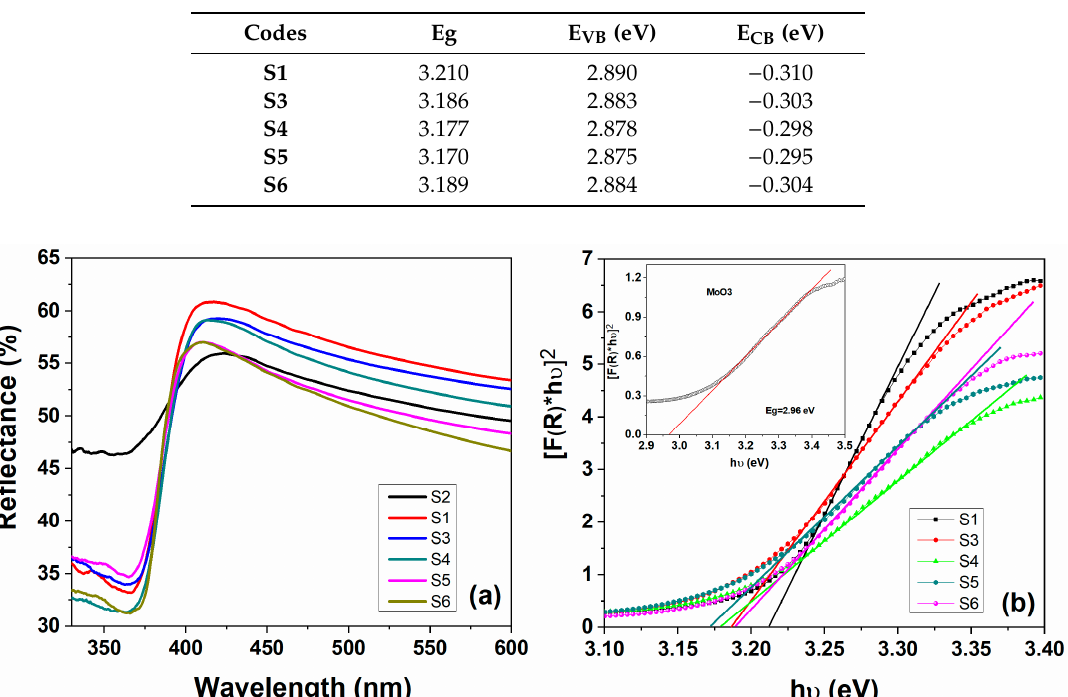
Figure 6. Di ff use reflectance ultraviolet–visible (UV–vis) spectra ( a ) and plots of [ F ( R ) h ϑ ] 2 versus h υ Figure 6. Diffuse reflectance ultraviolet–visible (UV–vis) spectra ( a ) and plots of [(cid:1832)((cid:1844))ℎ(cid:2036)] (cid:2870) versus h υ ( b ) for pure ZnO (S1), MoO 3 (S2) ( inset ), and ZnO:MoO 3 (S3 → S6) nanostructures. ( b ) for pure ZnO (S1), MoO 3 (S2) ( inset ) , and ZnO:MoO 3 (S3 → S6) nanostructures. The plots of [ F ( R ) h ϑ ] 2 as a function of the photon energy ( h ϑ ) of all the materials are presented in The plots of [(cid:1832)((cid:1844))ℎ(cid:2036)] (cid:2870) as a function of the photon energy ( ℎ(cid:2036) ) of all the materials are presented (Eg) were obtained. The pure ZnO material has an Eg value of 3.21 eV, this value is in good